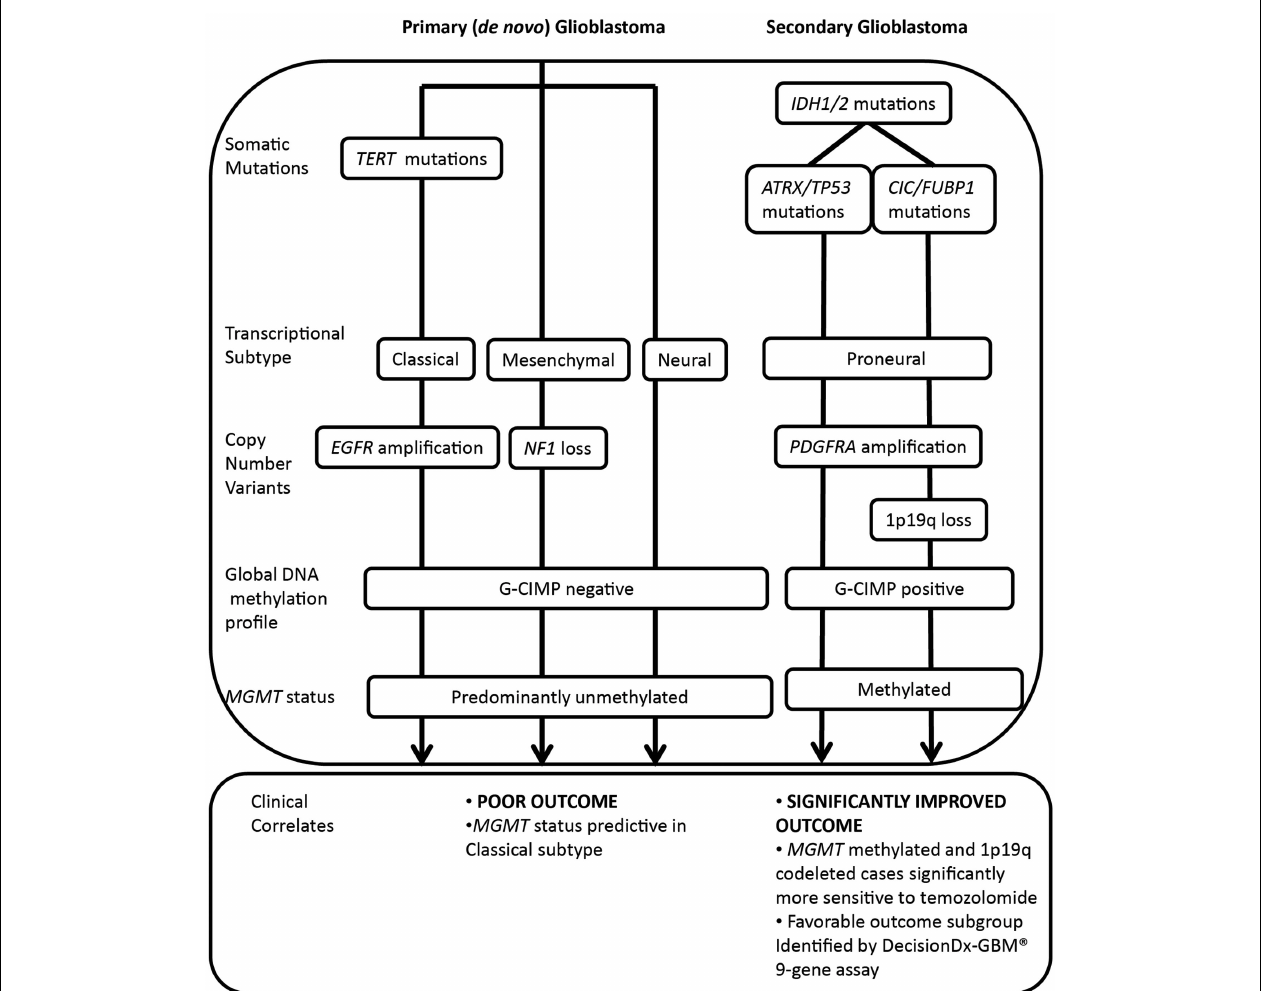
neural phenotypes, whereas secondary glioblastomas tend to display a proneural phenotype that shifts toward a mesenchymal phenotype with recurrence.The significantly improved outcome of the proneural subset is due to the G-CIMP phenotype, established by IDH1/2 -mediated metabolic reprogramming of the epigenome. Primary glioblastomas and a subset of proneural tumors are glioma-CpG island hypermethylator phenotype (G-CIMP) negative, and a large proportion are MGMT unmethylated. Both classical and mesenchymal transcriptional subtypes benefit from concurrent chemoradiotherapy, however, MGMT status is only predictive of treatment response in the classical